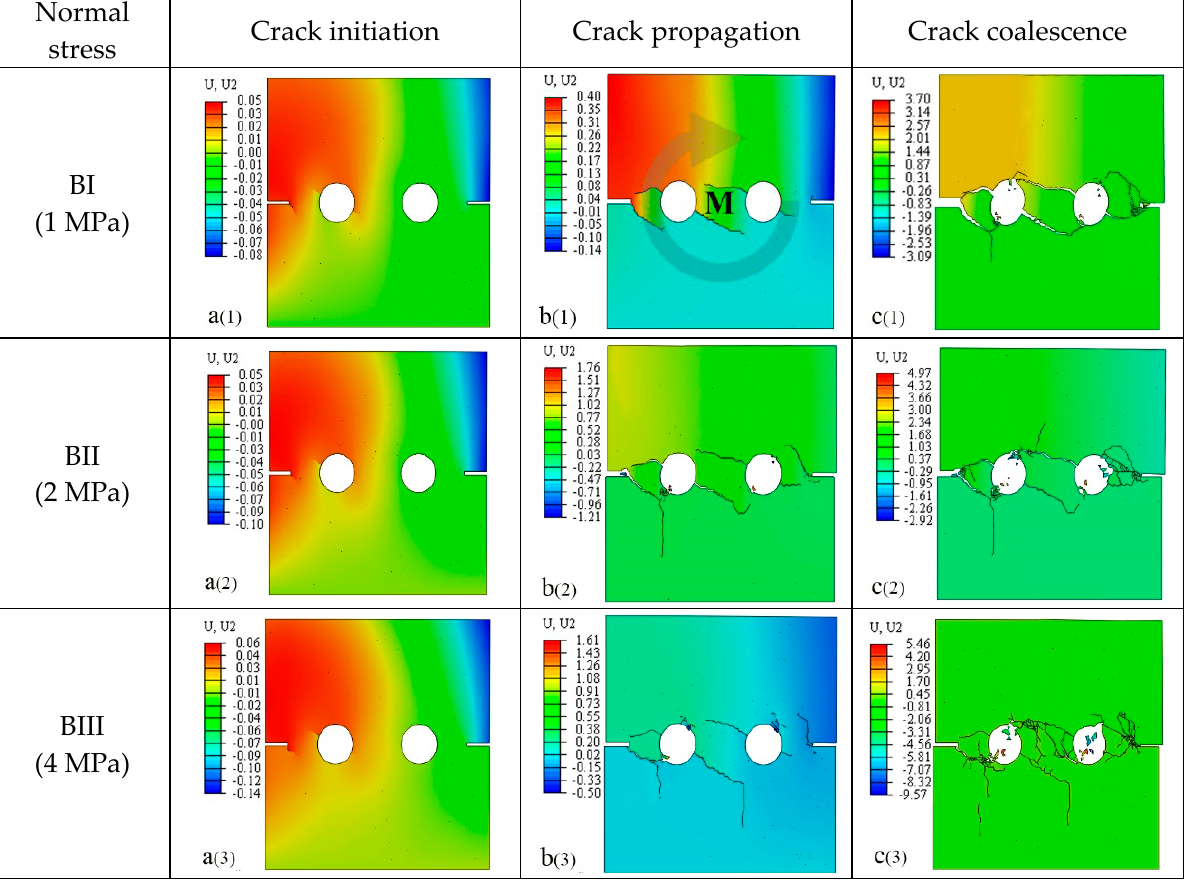
Figure 10. Normal displacement field at the persistency of shearing rate of 0.02 mm/s and different normal stress. a(1)–a(3). The stage of crack initiation; b(1)–b(3). The stage of crack propagation; c(1)–c(3). The stage of crack coalescence.